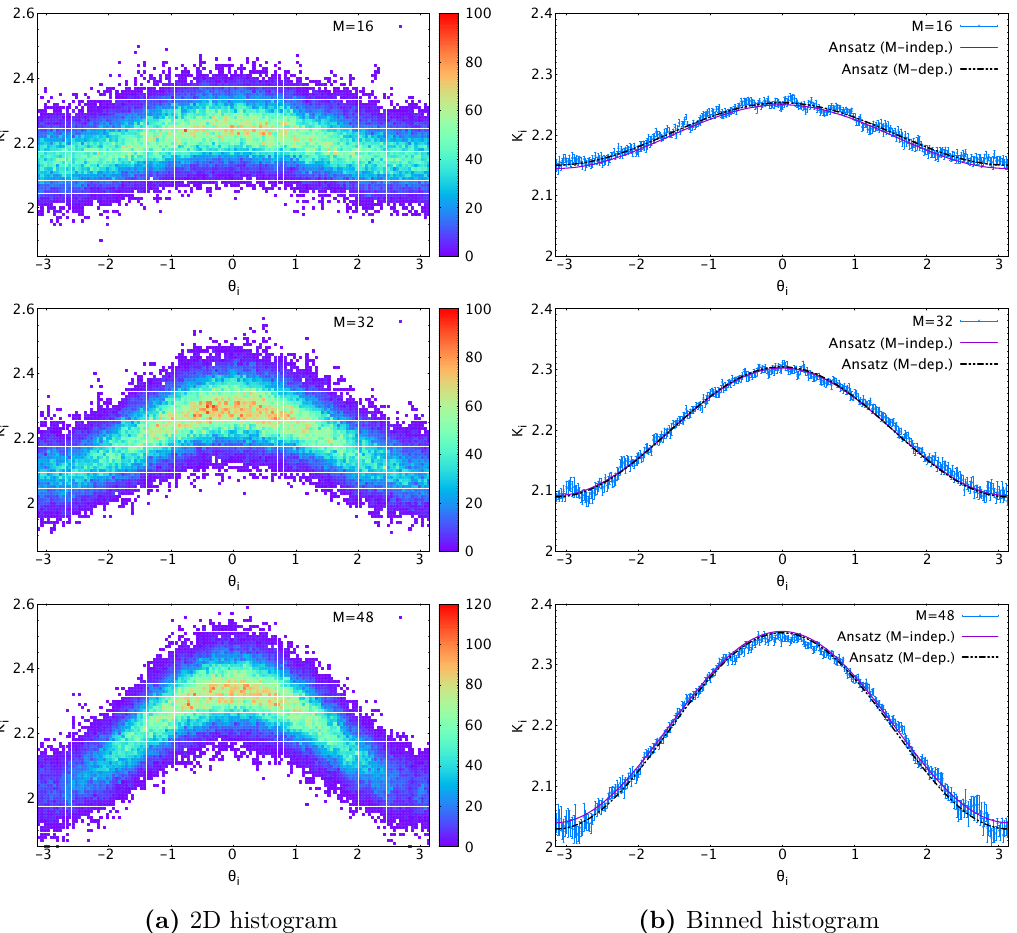
Figure 18. Yang-Mills matrix model, θ i vs K i , in a constrained simulation with N = 64 , L = 24 , M = 16 , 32 and 48 at T = 0 . 885 . We used 1500 configurations for each M (the total number of points is 64 × 1500 ). The center symmetry is fixed sample by sample such that P = | P | . (a) The two-dimensional histograms of ( θ i , K i ). Data points in the confined and deconfined sectors are shown together. (b) The averaged K i within the narrow bin ∆ θ = 0 . 02 . The magenta lines are eq. (4.9), with r 0 and r 1 from figure 12. The black lines are eq. (4.15), with variances from table 3. The error bars in each figure are obtained by jackknife